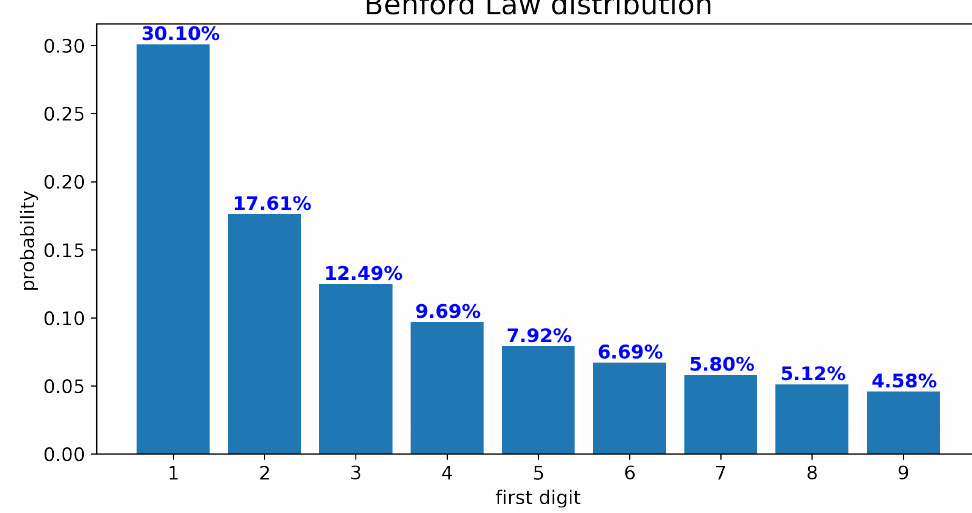
Figure 1. First digit’s probability distribution in a set satisfying Benford’s